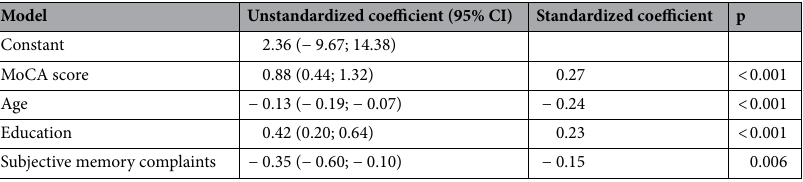
Table 3. Multivariable regression